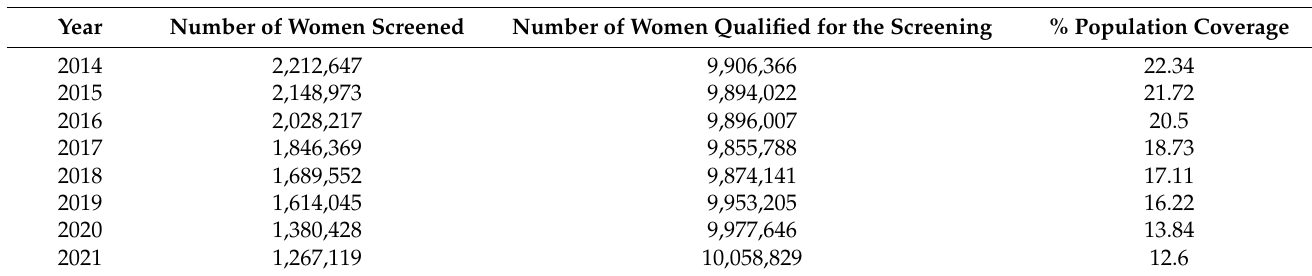
Table 3. Population coverage of publicly funded cervical cancer screening as part of a prevention program in Poland.